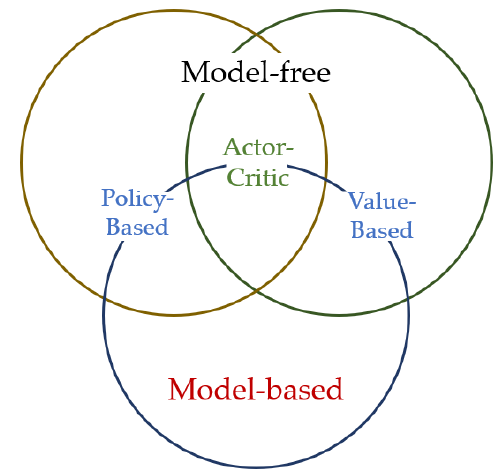
Figure 5. The classification of DRL algorithms